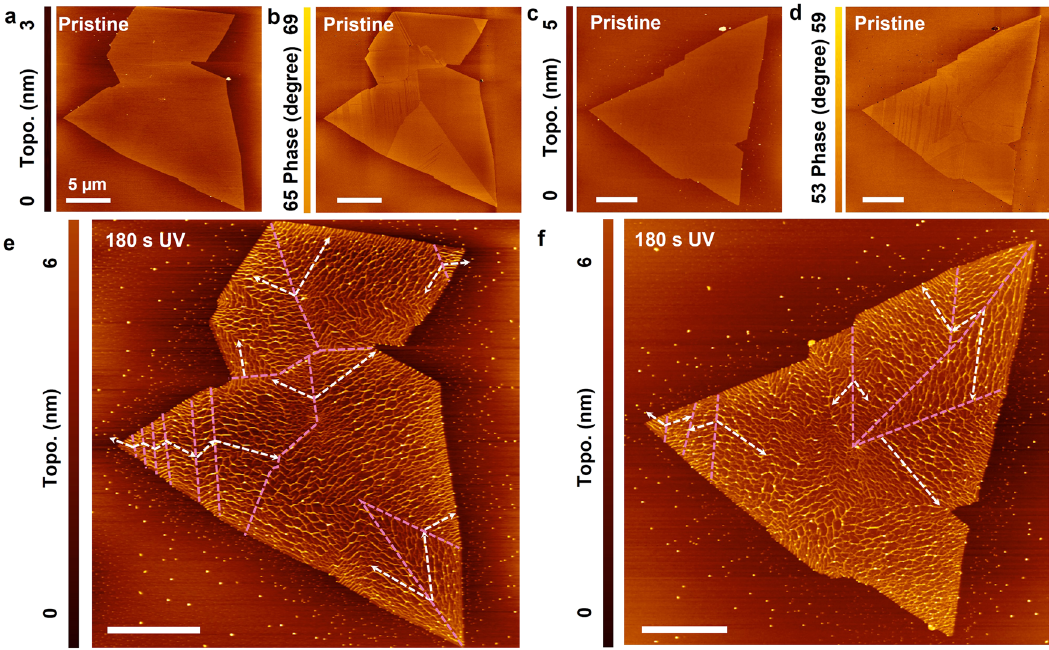
Fig. 7 The results of DFM characterizations and wrinkling behavior of 1L-ReS 2 as grown on fl uorophlogopite mica substrate after 180 s UV treatment. a – d The DFM topography and phase images for pristine 1L-ReS 2 . e , f The DFM images for 180 s UV treated ReS 2 fl ake in a and c , respectively. The white dashed lines with arrows indicate the different directional wrinkles and the sub-domain boundaries are marked by purple dashed